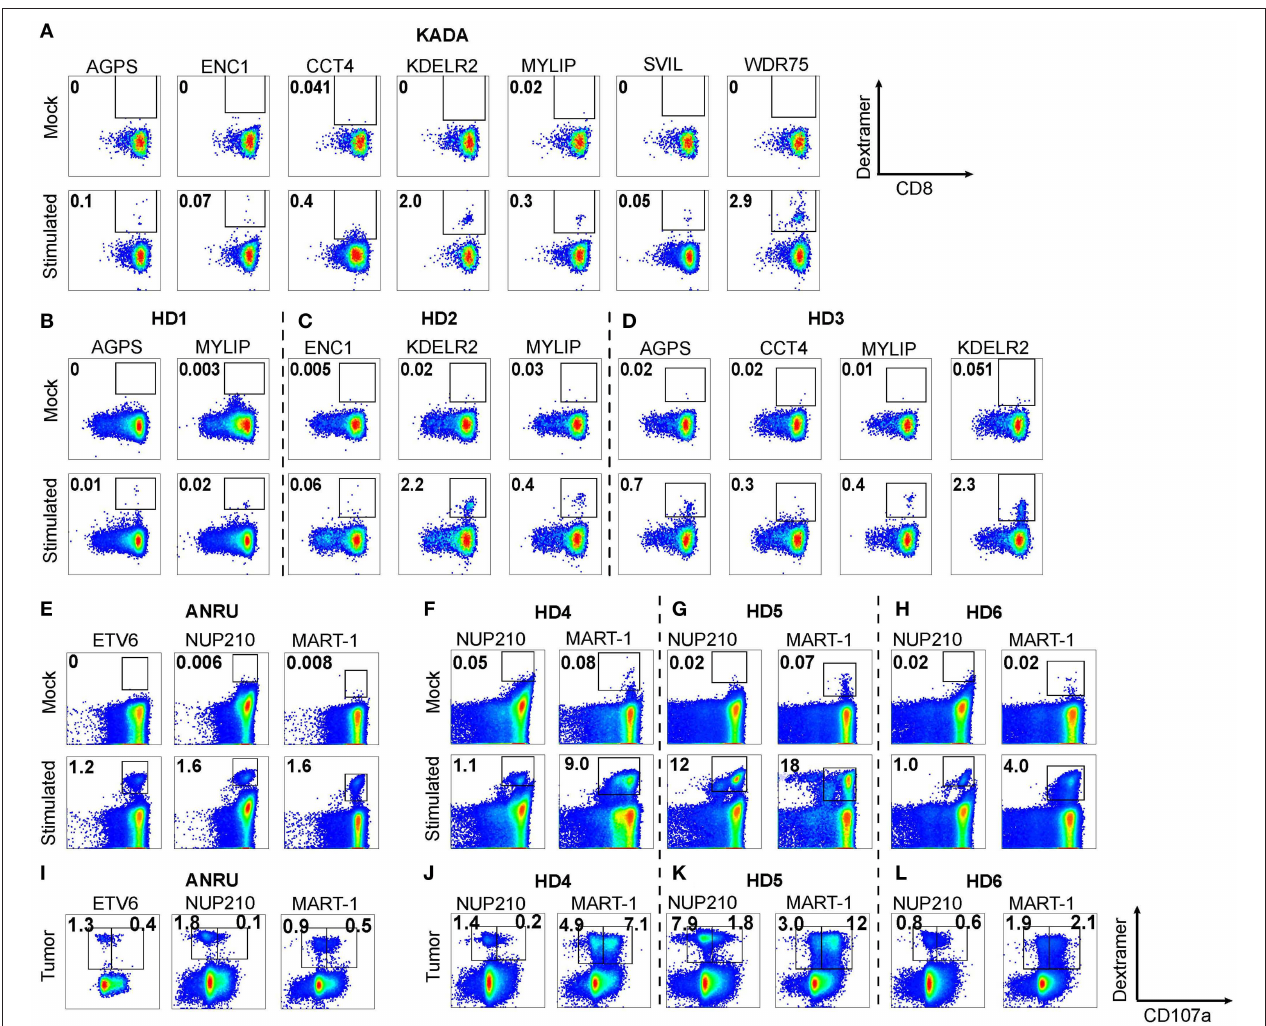
FIGURE 4 | Expansion of neoepitope peptide-specific T cells from PBMC. Dendritic cells from KADA (A) or ANRU (E) were loaded with their respective TIL-activating and/or tumor-presented peptides and used to stimulate autologous CD8T cells. The same experiment was performed using three healthy donors for each peptide set ( B–D , KADA neoepitopes; F–H , ANRU neoepitopes and MART-1). After 10 days of expansion, the cells were stained with corresponding HLA-A2/peptide dextramers and analyzed by flow cytometry. Dot plots are gated on lymphocytes/singlets/live cells and frequency indicates %dextramer + out of CD8 + cells. For ANRU epitopes, the function of the neoepitope specific T cells was assessed by re-stimulation with ANRU tumor cells and evaluated by CD107a staining ( I , ANRU; J–L , healthy donors). Only positive stainings are shown. Dot plots are gated on lymphocytes/singlets/live cells/CD8 + cells and frequency indicates % dextramer + CD07a − or dextramer + CD107a + of CD8 +